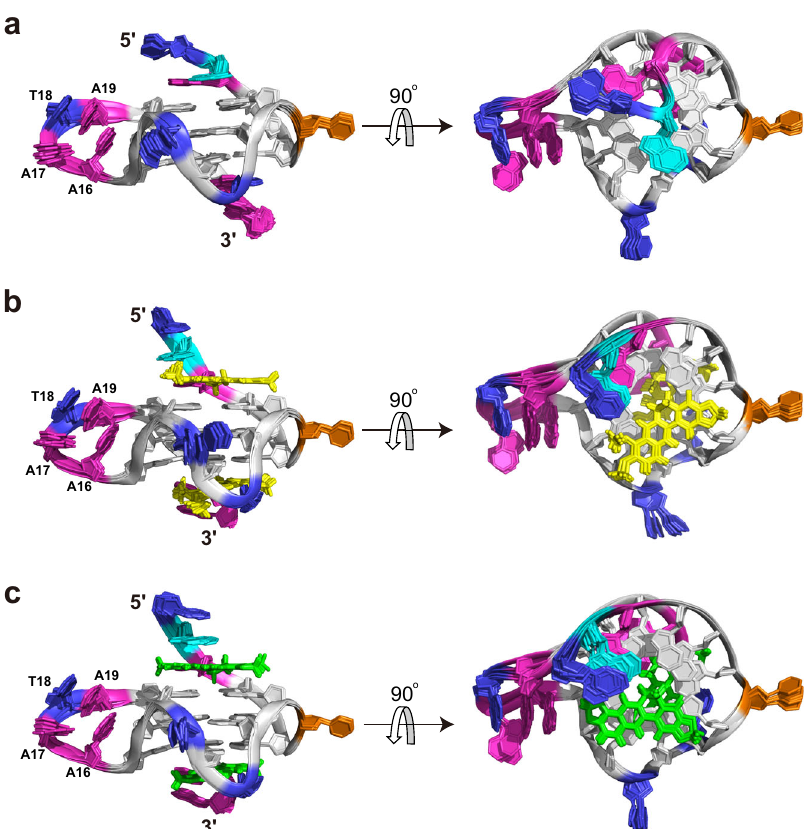
Fig. 4 | NMR solution structures of KRAS -G4 and its complexes with berberine and coptisine. Superposition of the ten lowest energy NMR structures of the free KRAS -G4 ( a ), berberine- KRAS -G4 ( b ), and coptisine- KRAS -G4 ( c ) by NOE-restrained